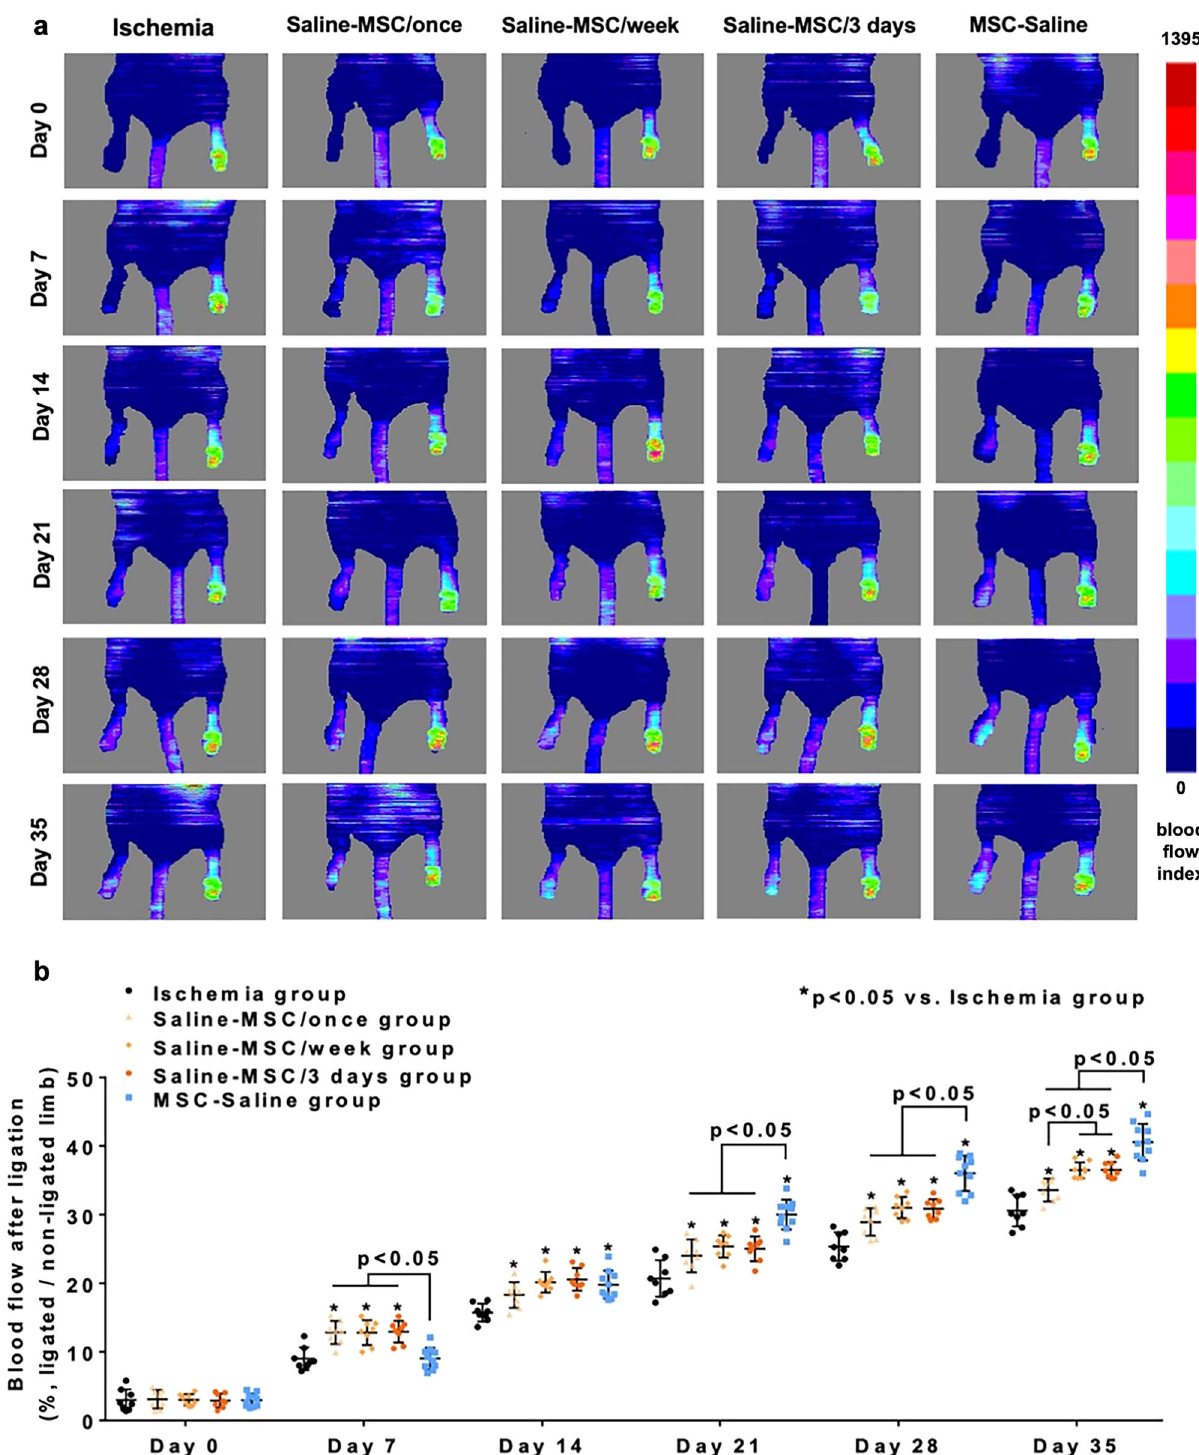
Fig. 1 Comparison of intravenous administration of hiPSC-MSCs versus intramuscular hiPSC-MSCs delivery. To evaluate blood perfusion in the groups that received intravenous hiPSC-MSCs infusion without intramuscular hiPSC-MSCs transplantation, Laser Doppler imaging analysis was performed immediately and every week following femoral artery ligation ( a ). A single or repeated intravenous administration of hiPSC-MSCs in the Saline-MSC/once, Saline-MSC/week or Saline-MSC/3 days groups signi fi cantly increased blood perfusion from day 7 onwards compared with the ischemia group. Moreover, repeated intravenous hiPSC-MSCs infusion further improved blood perfusion at day 35. Nonetheless intramuscular hiPSC-MSC transplantation in the MSC-Saline group showed a superior bene fi cial effect over repeated intravenous hiPSC-MSC infusion in the Saline-MSC/week and Saline-MSC/3 days groups ( b